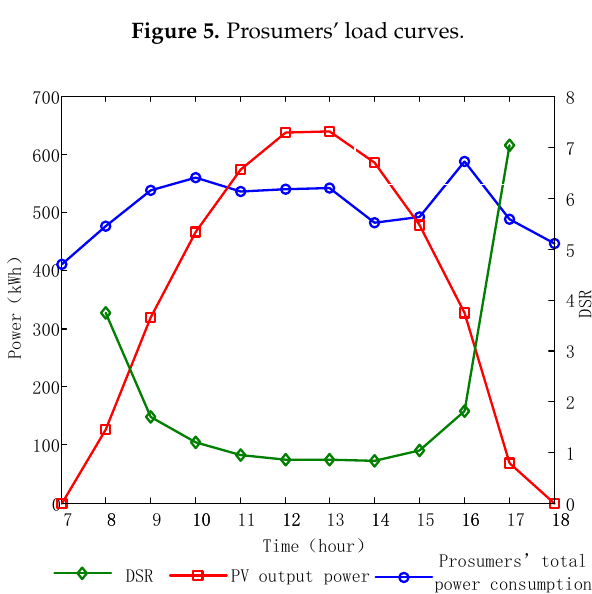
Figure 5. Prosumers’ load curves.